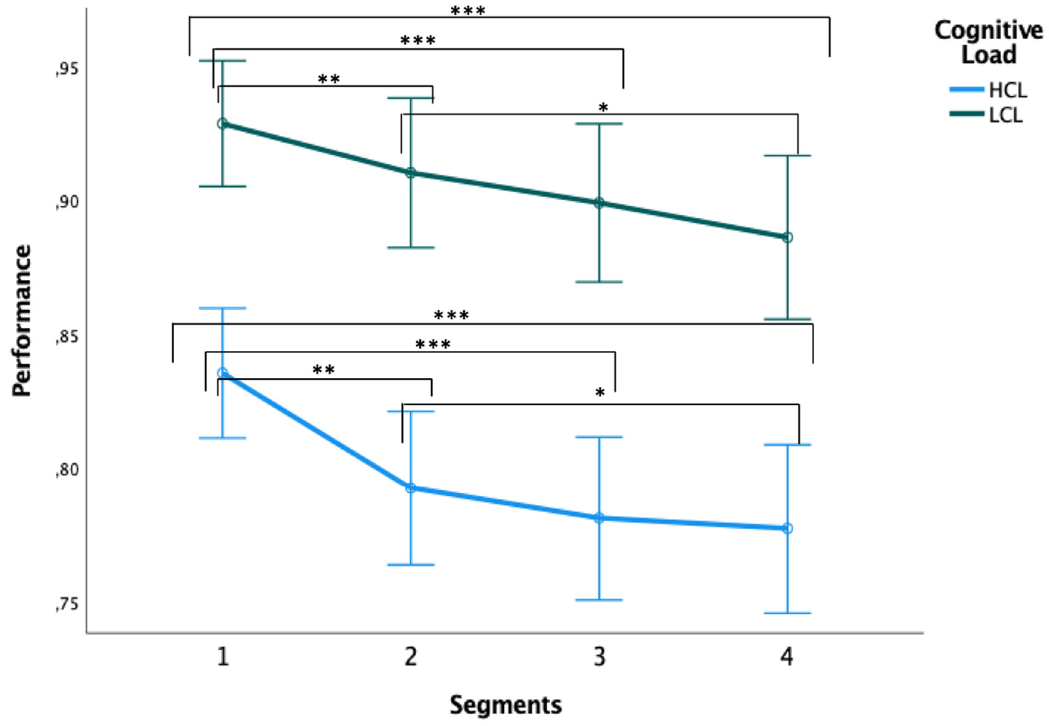
Figure 9. Performance (accuracy percentage) across the four 4 min segments in the 16 min duration TloadDback task. Note: LCL = low cognitive load; HCL = high cognitive load; * p < 0.05, ** p < 0.01, *** p < 0.001. Error bars represent standard errors.